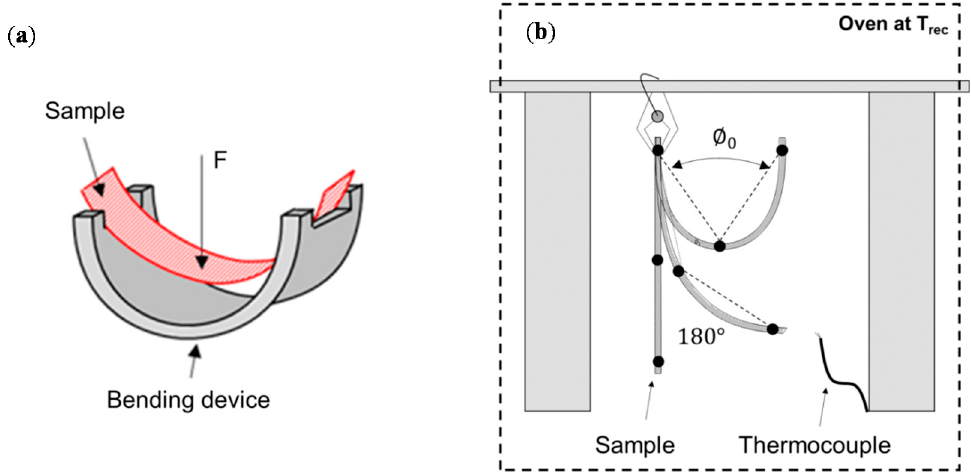
Figure 3. Schematic representation of the bending device; ( a ) and the shape-recovery scenario; ( b ) for the isothermal-recovery experiments.